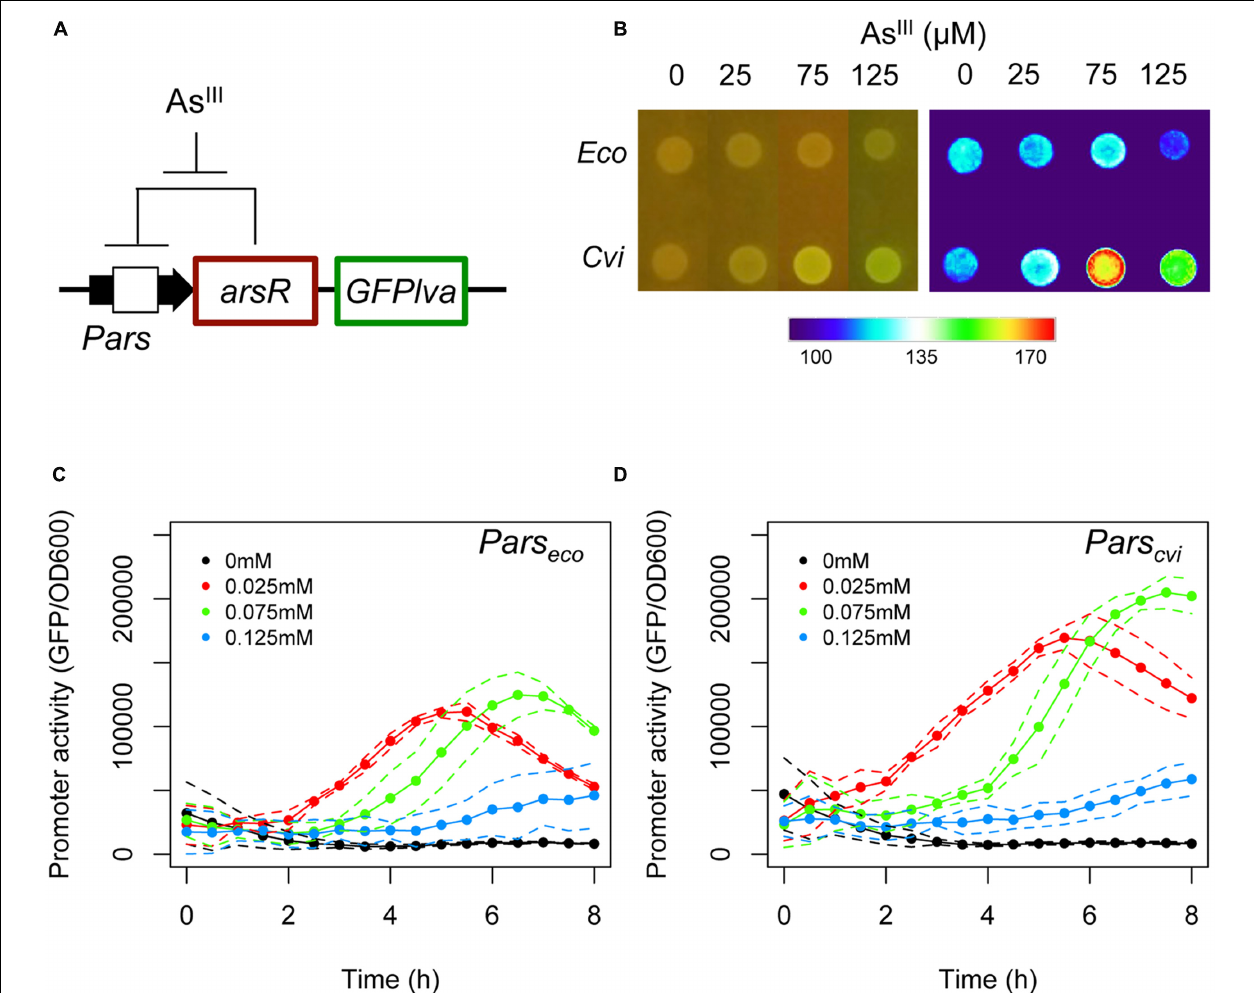
FIGURE 1 | Analysis of the natural ars circuits from Escherichia coli and Chromobacterium violaceum . (A) Schematic representation of the feedback circuit controlling GFPlva expression. (B) Induction of the ars system from E. coli and C. violaceum on agar plates using increasing concentrations of As III for 6 h. The left panel represents bacterial colonies grown in agar plates and at the right panel the GFP intensities were converted to a false color scale to facilitate the visualization of the differences. (C,D) Induction kinetics of the ars system from E. coli (C) and C. violaceum (D ) in wild type (W3110) E. coli in M9 liquid media exposed to increasing concentrations of As III . Solid lines represent the average of three independent experiments, whereas dashed lines represents the upper and lower limits of standard